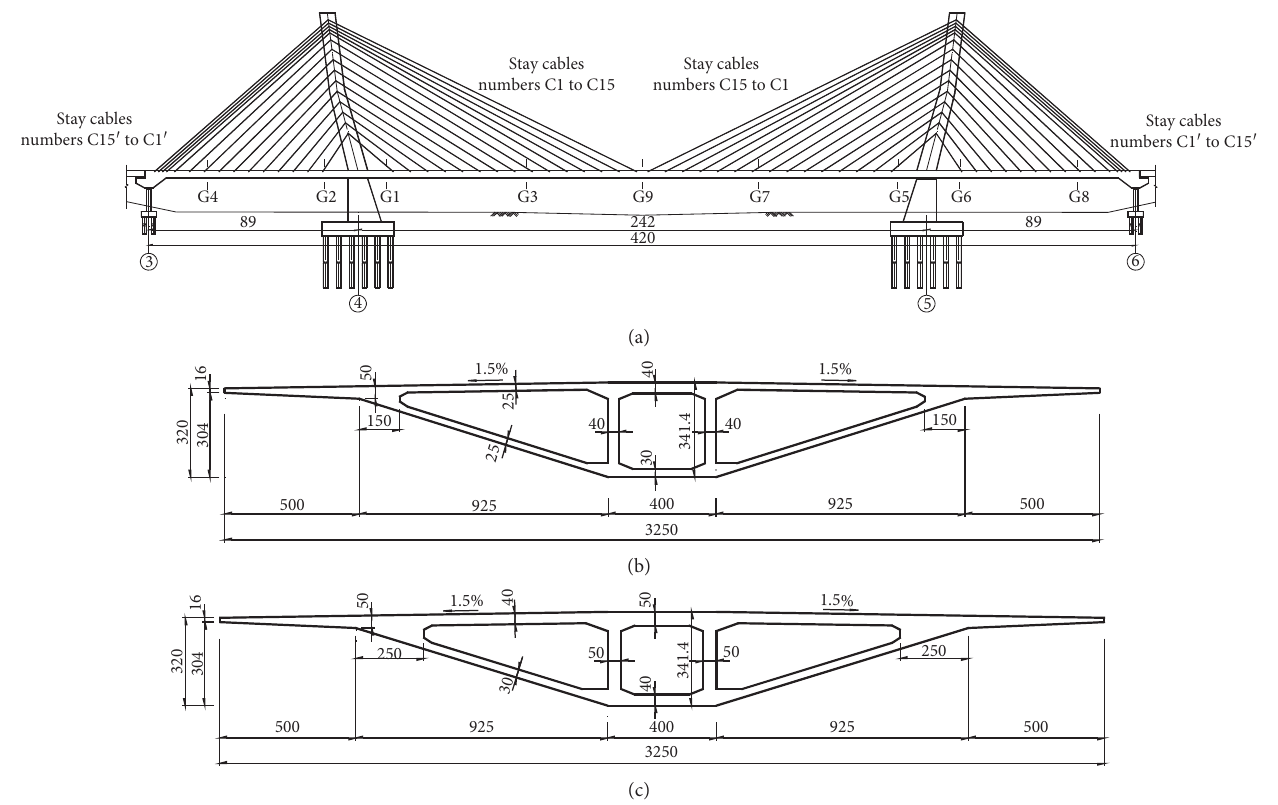
Figure 1: Structural drawing of bridge, (a) main bridge arrangement (unit: m), (b) cross section of midspan girder (unit: cm), and (c) cross section of side-span girder (unit: